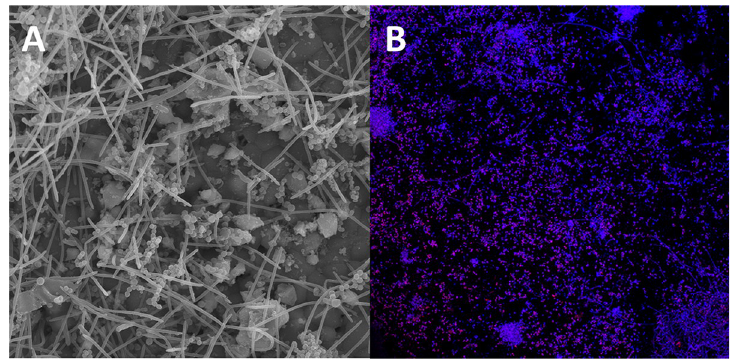
Fig 2. Micrographs representing the multispecies-biofilms after 96 hours of growth. (A) Scanning Electron Microscopy (SEM) depicting the structure of the biofilm. Note the microcolonies organized in clusters with F . nucleatum connecting them; (B) Confocal Laser Scanning Microscopy combined with Fluorescence In Situ Hybridization (CLSM-FISH). The ALEXA Fluor 488 probe detected the 16S rRNA P . gingivalis (cells in purple) within the multispecies-biofilm (other bacterial species in blue stained with DAPI).